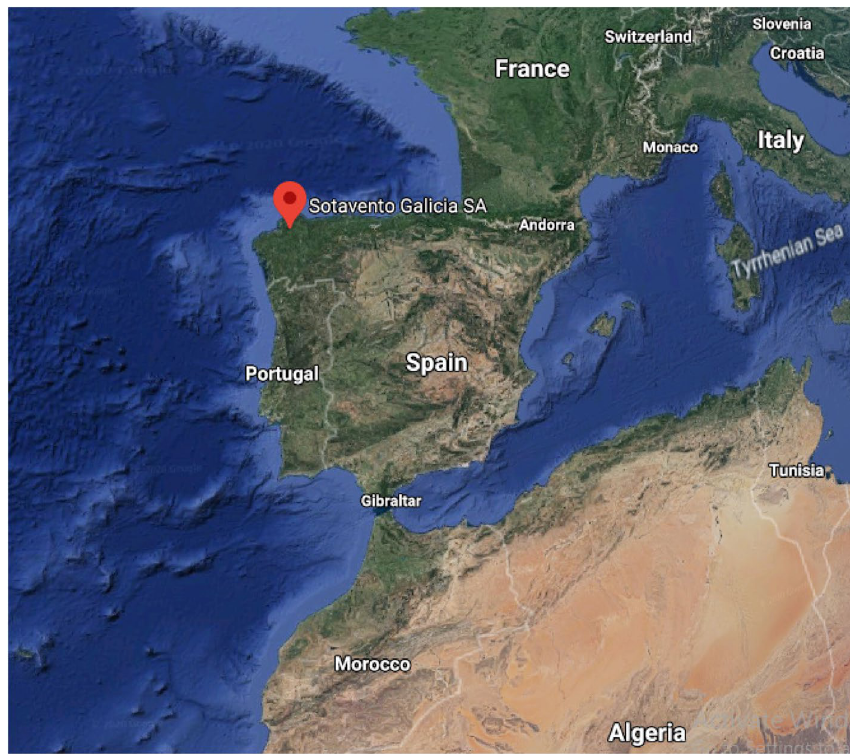
Fig. 4 The location of the Sotavento wind farm shown on Google